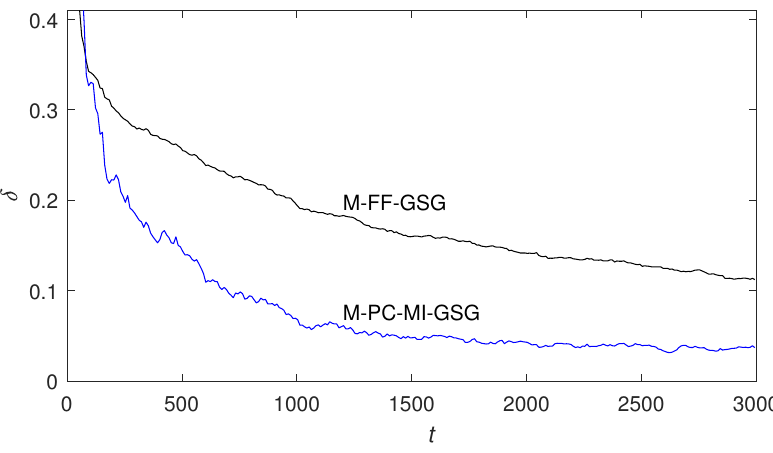
Figure 8. The comparison of algorithms M-FF-GSG with